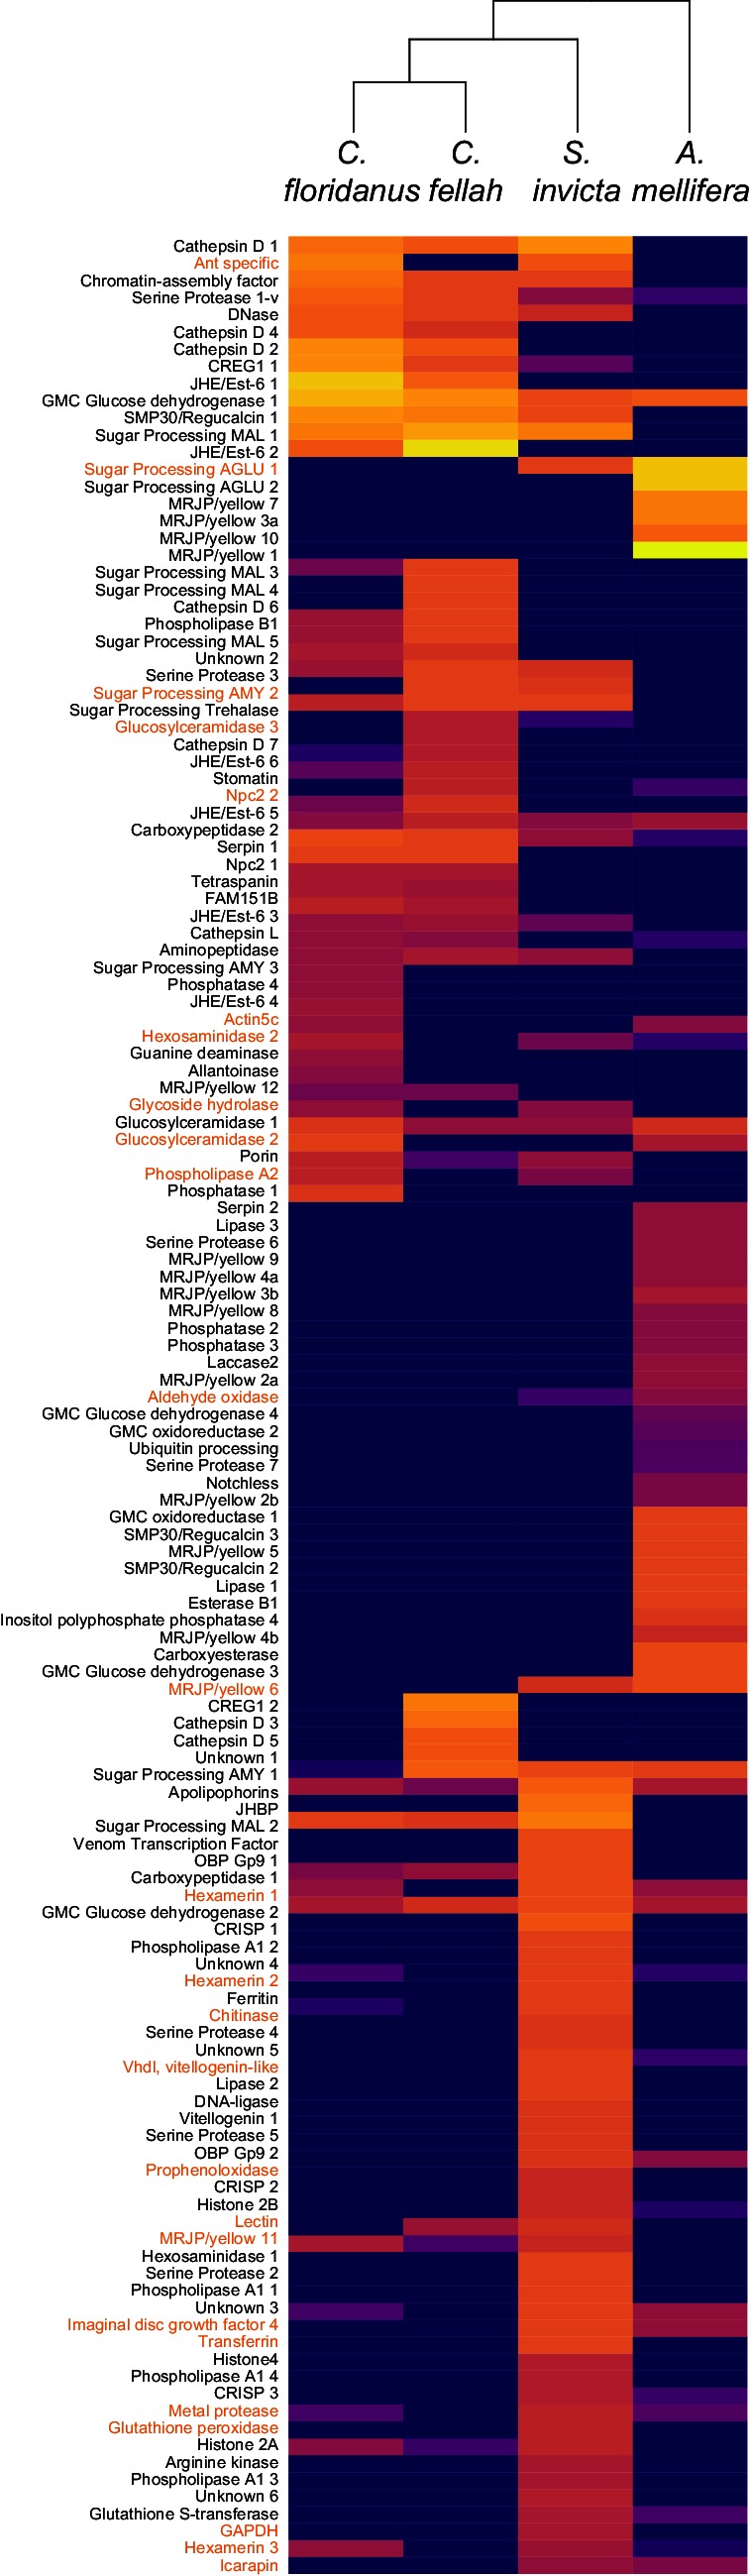
Heat map showing the percentage of total molecular-weight normalized spectra in trophallactic fluid samples assigned to each protein in three ant species and the European honey bee, averaged over all in-colony samples for that species.Sample sizes: C. floridanus (n = 15), C. fellah (n = 6), S. invicta (n = 3), A. mellifera (n = 6). The 26 protein ortholog groups whose presence/absence in TF was inconsistent with phylogeny (e.g., present in only C. floridanus and A. mellifera) are shown in orange. Protein names are shown on the left. Identifiers can be found in the table in Figure 5—figure supplement 1.